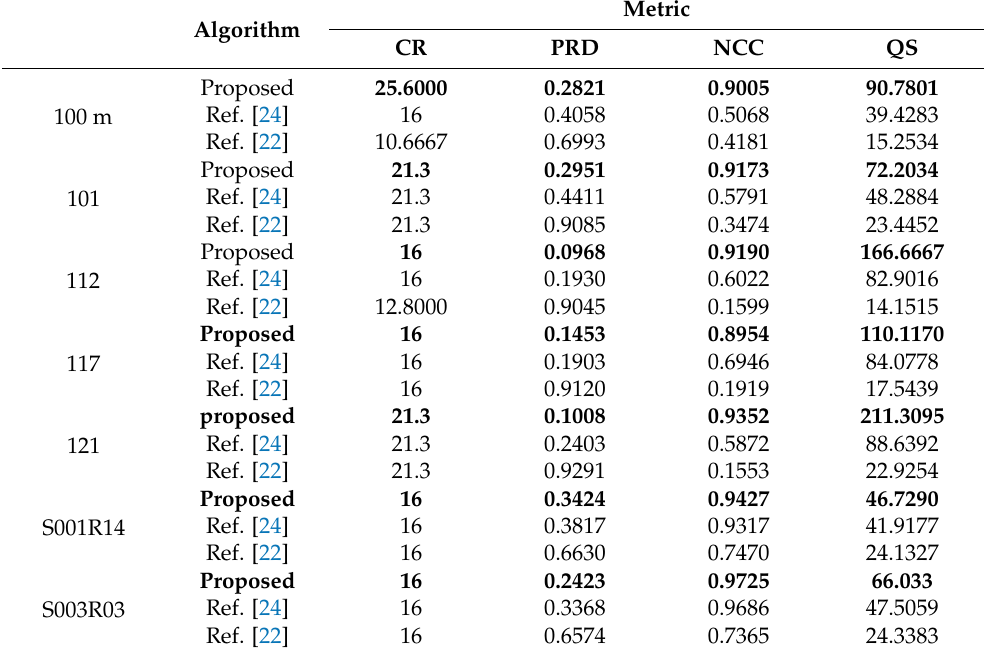
Table 3. Comparison with other techniques.